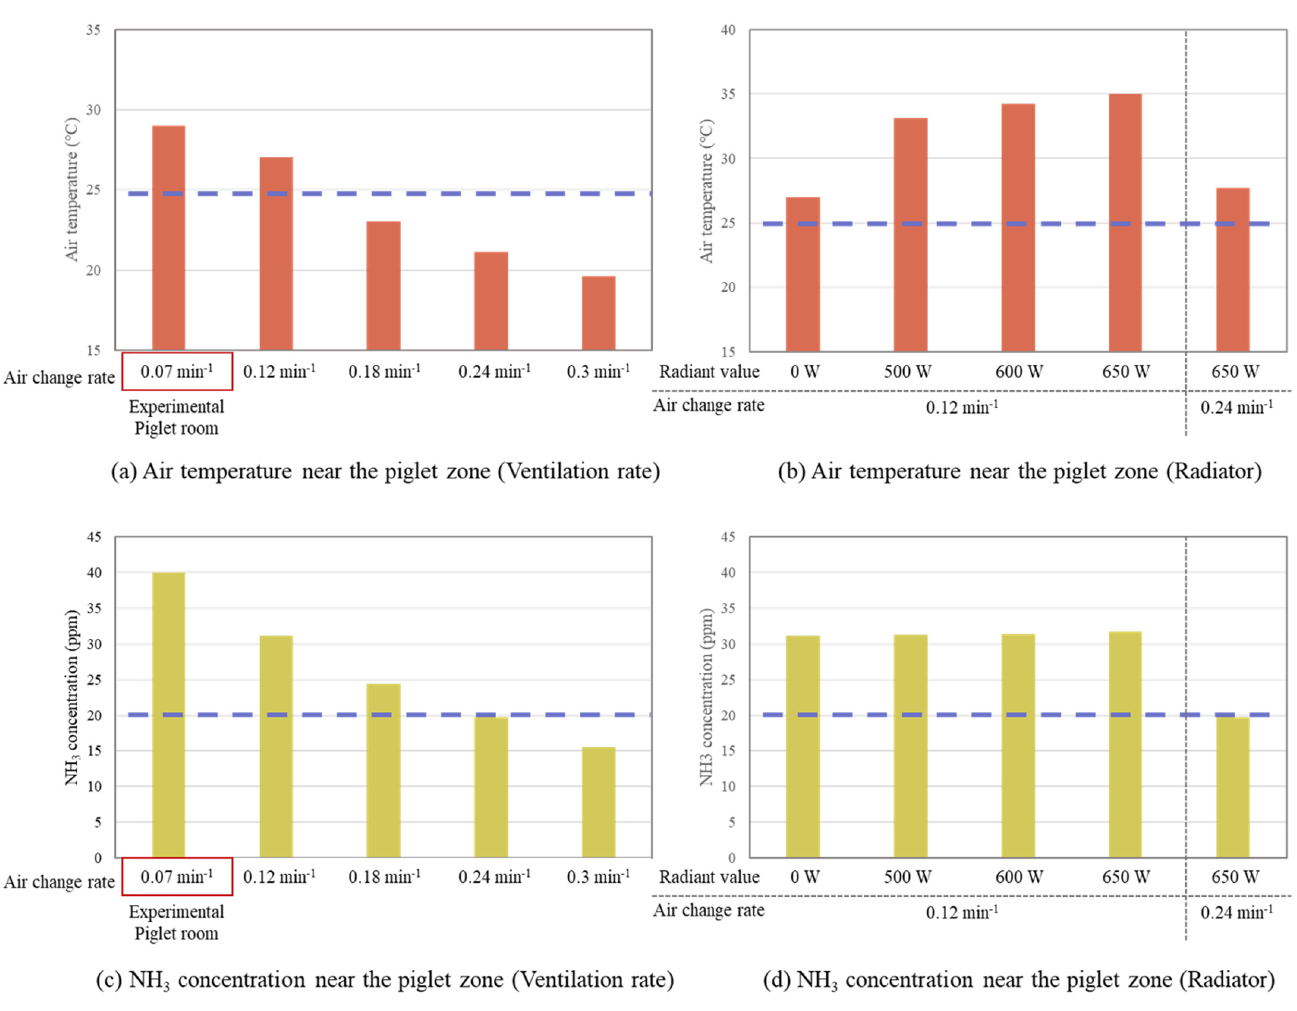
Figure 15. The computed results of internal temperature and ammonia concentration inside the ex- perimental piglet house according to the ventilation rate and radiator conditions . experimental piglet house according to the ventilation rate and radiator